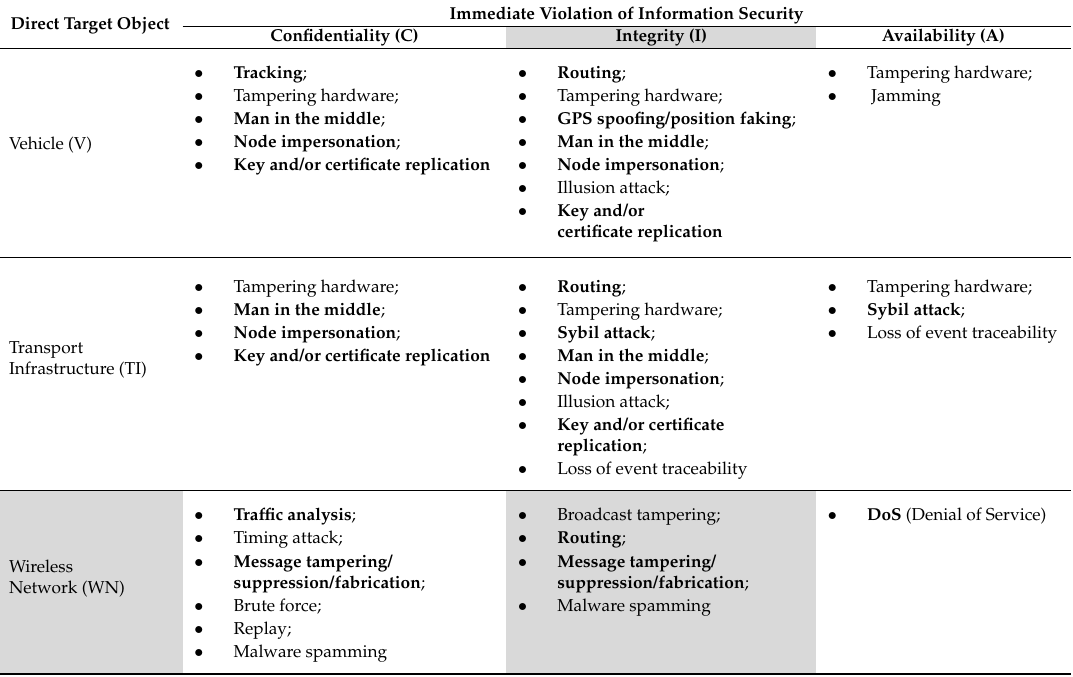
Table 2. Cyber threats taxonomy for vehicular ad hoc networks/intelligent transportation systems